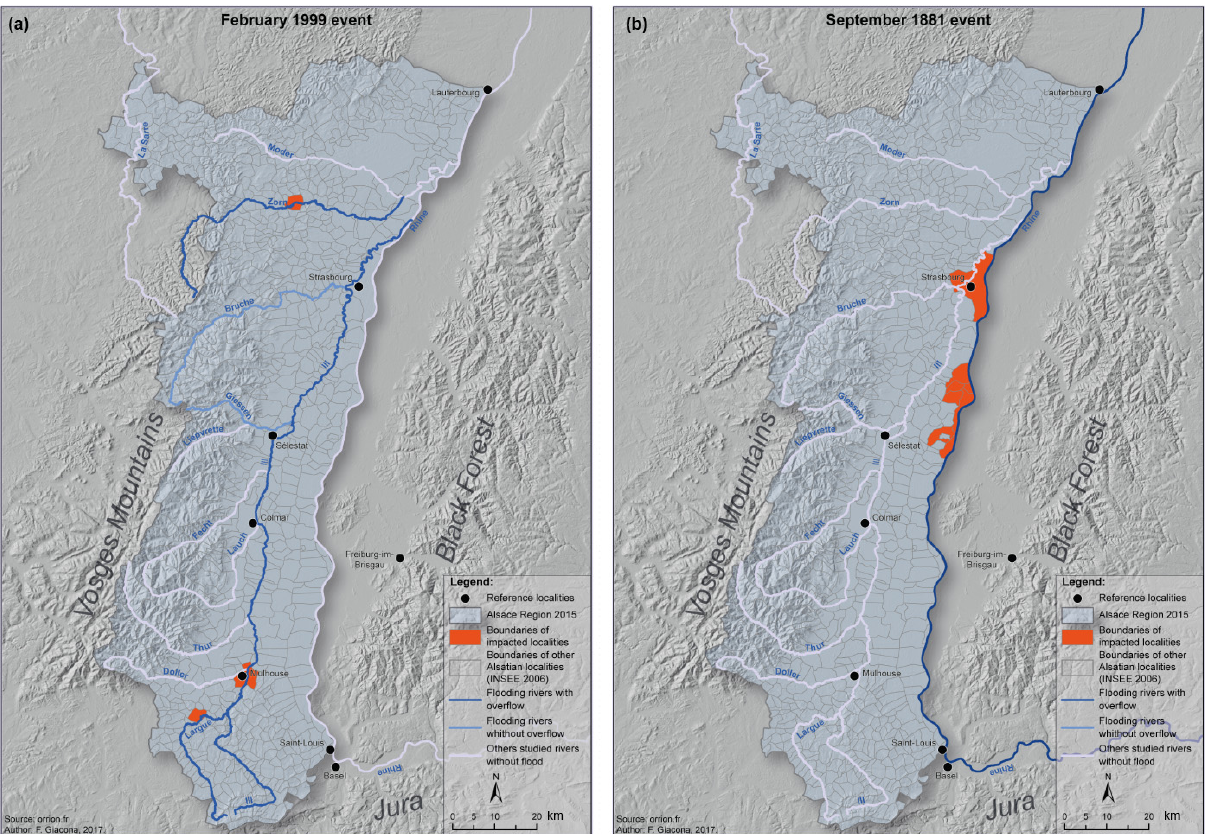
Figure 4. Maps of specific class II events. (a) February 1999 event. T configuration (Alsatian tributaries of the Rhine River alone). Extent score: 1. Damage score: 1. Overflowed Largue, Ill, and Zorn rivers caused material damage and impacted three municipalities. Giessen and Bruche rivers were flooded without overflow. This event has unknown causes. It is known from seven sources. (b) September 1881 event. R configuration (Rhine River alone). Extent score: 0. Damage score: 2. Overflowed Rhine River caused environmental, functional, and material damage and impacted eight municipalities. This event is attributed to heavy rainfall and is known from five